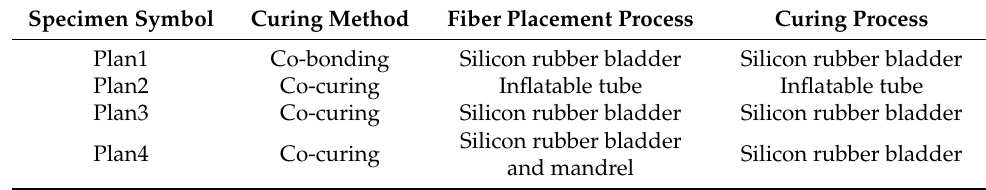
Figure 3. Filling diagram. Table 2. Filling form in fiber placement and curing process.